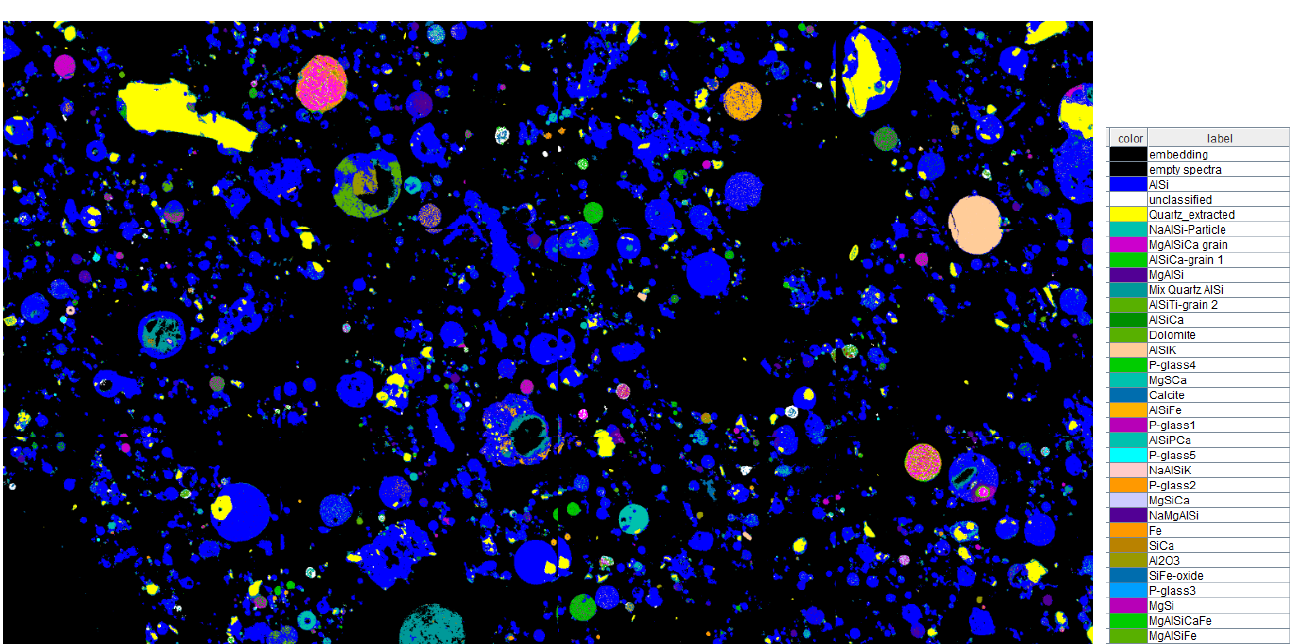
Figure 12. Large-area PARC phase image with individual phases in unreacted FA (width 1024 μm) ( left ); legend of identified phases ( right ).